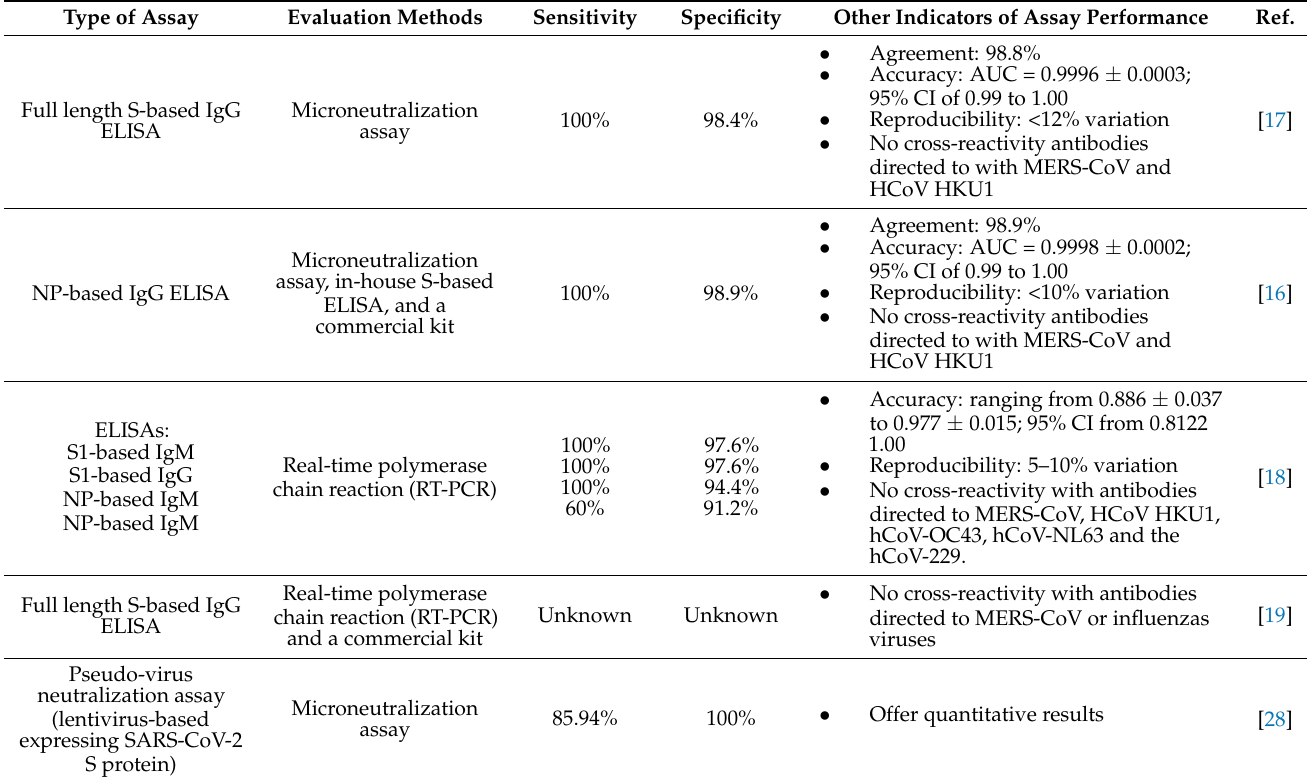
Table 1. Summary of in-house COVID-19 immunoassays developed in Saudi Arabia. The assay principle, the evaluation methods, and the performance indicators are